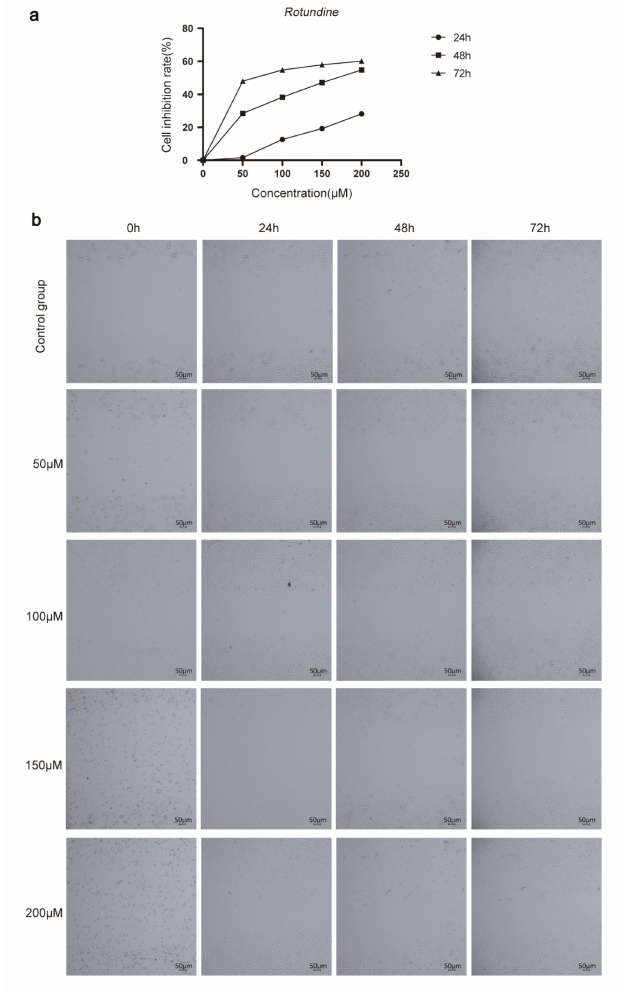
Figure 1. Rotundine intervention in SW480 cells experiments. ( a ) MTT assay. ( b ) Cell scratch